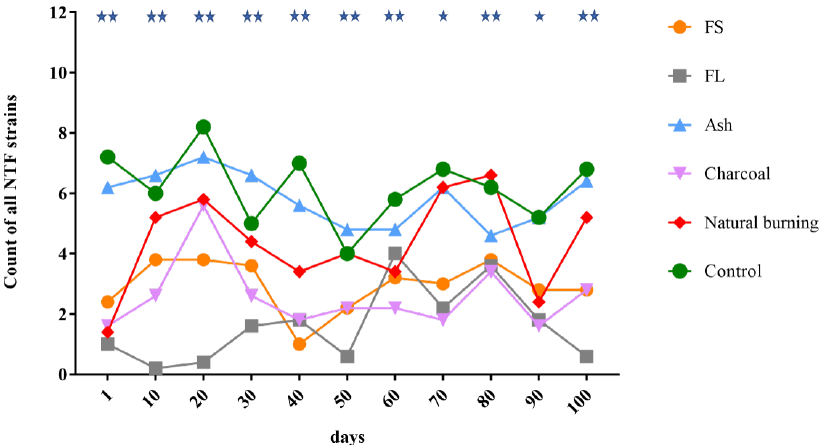
Figure 3. Dynamic of the counts of all nematode-trapping fungi (NTF) strains in each treatment and difference among treatments. ★ : p < 0.05; ★★ : p < 0.01. FS: treated with flame gun and the burn duration was 20 min; FL: treated with flame gun and the burn duration was 60 min; Charcoal: treated with Charcoal; Ash: treated with cooled ash; Natural burning: treated with dry pine needles placed directly on the soil and let burn naturally and ashes were left on the soil after burn; Control: without any treatment. any